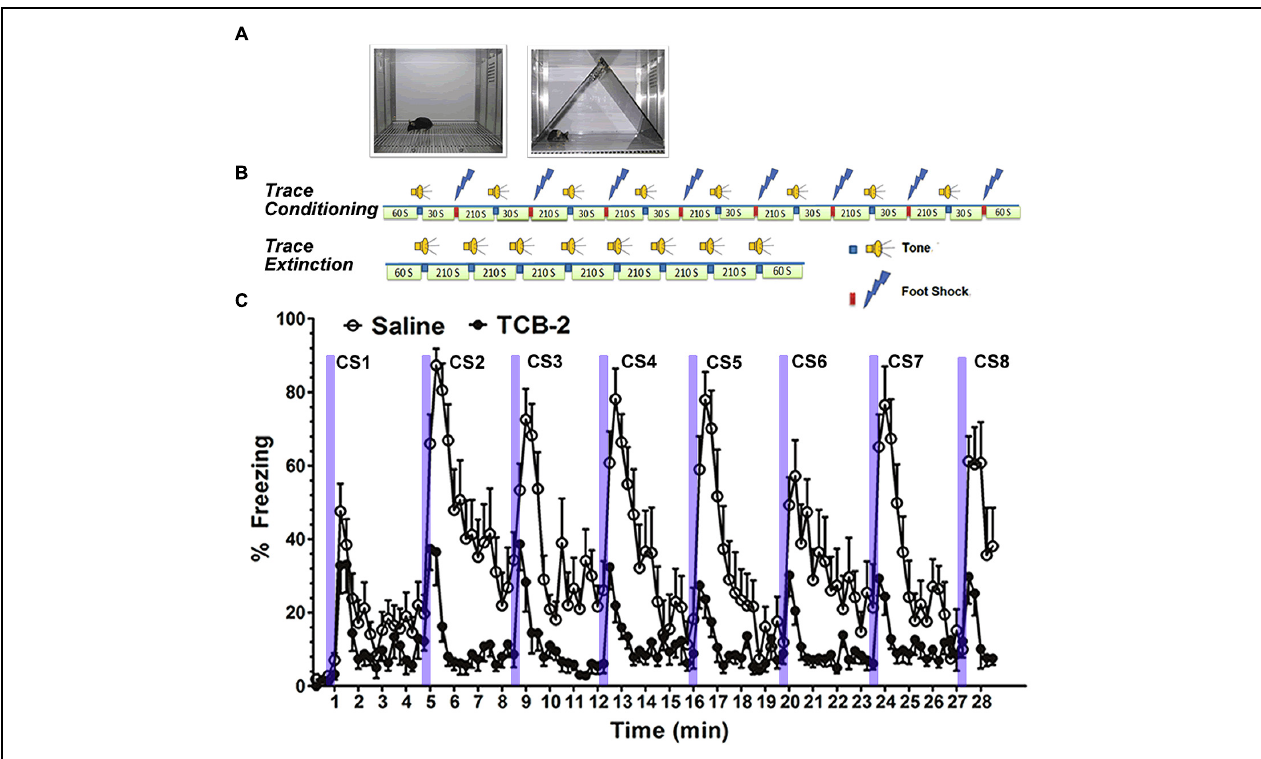
FIGURE 2 | Stimulation of 5-HT 2A Rs enhances the acquisition of extinction of trace fear memory. (A) Left, a chamber for fear conditioning (Context A) and contextual fear memory test; right, Context B, a modified chamber with different color, context, light density, and odor for cued fear memory test. (B) Trace fear conditioning training procedure. After a 60-s habitation to Context A, a tone was presented for 15 s followed by 30 s stimulus-free interval, and then a 0.5-s, 0.75 mA foot shock (US) was presented. The CS–US pairing was repeated eight times with a 210-s intertrial interval (ITI). Mice were removed from the conditioning chamber and returned to their home cages 60 s after the final CS–US pairing. Trace fear conditioning extinction procedure. Sixty seconds after placing the mouse into the modified chamber, eight unpaired 15-s tone CS were presented with a 120-s ITI. (C) Mice that received TCB-2 (1.0 mg/kg, i.p.) before a trace fear memory extinction test exhibited accelerated acquisition of extinction as indicated by significantly lower freezing scores earlier in the course of extinction as compared to those of vehicle-treated mice. TCB-2 significantly decreased percent freezing from the second to eighth CS presentation (Zhang et al.,